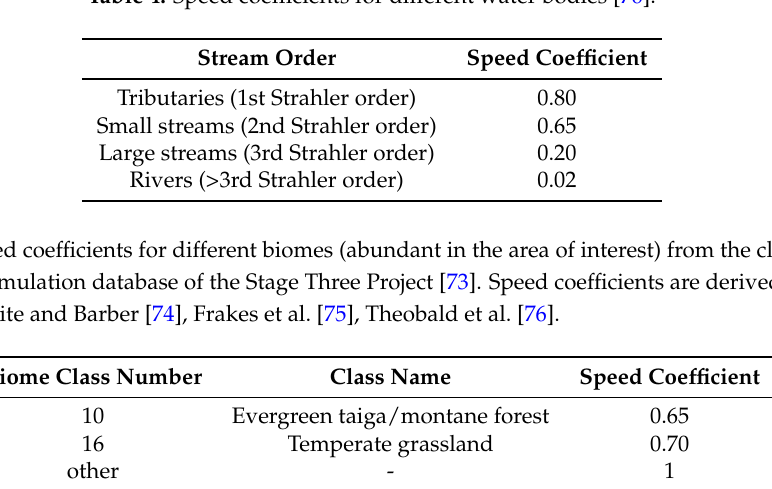
Table 4. Speed coefficients for different water bodies [76].